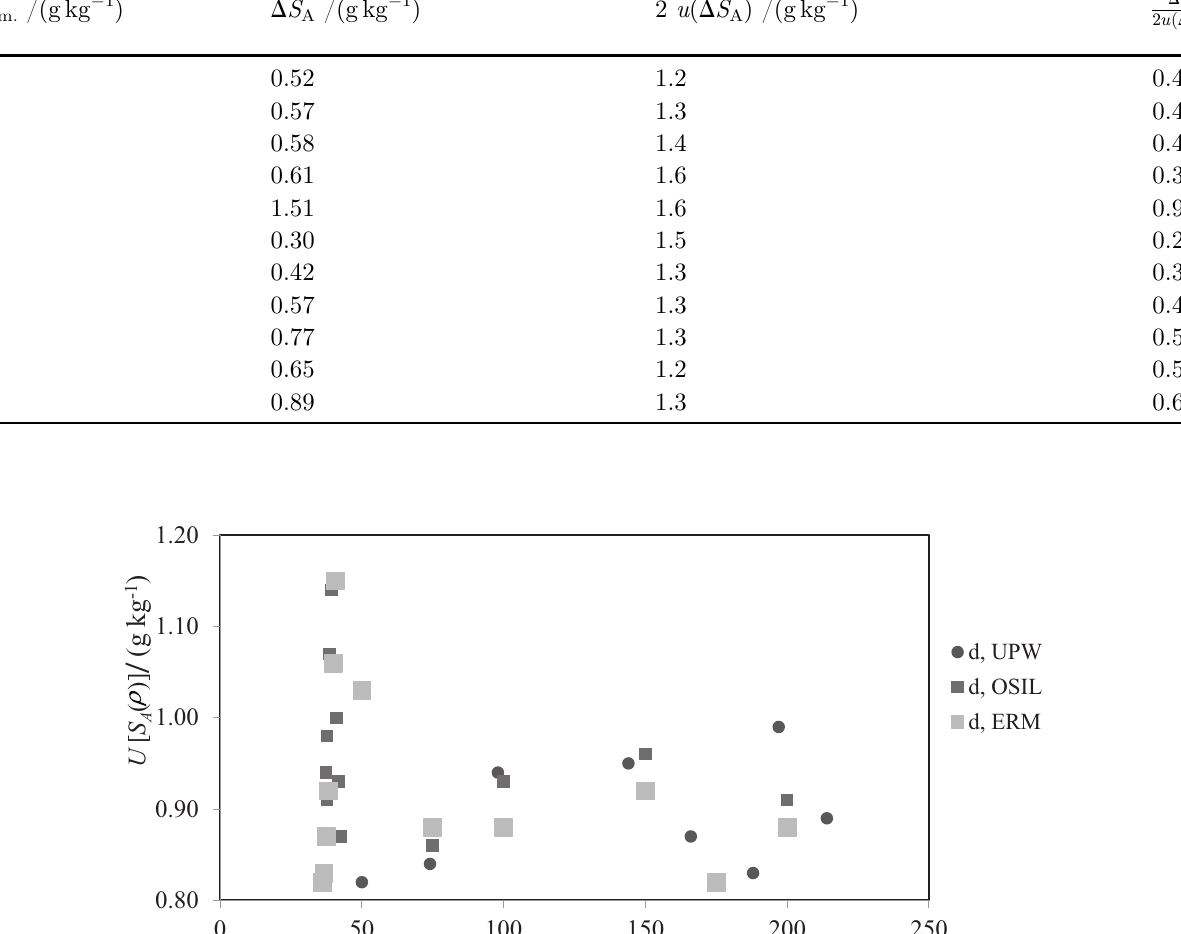
) value for NaCl in ERM SSW solutions. A